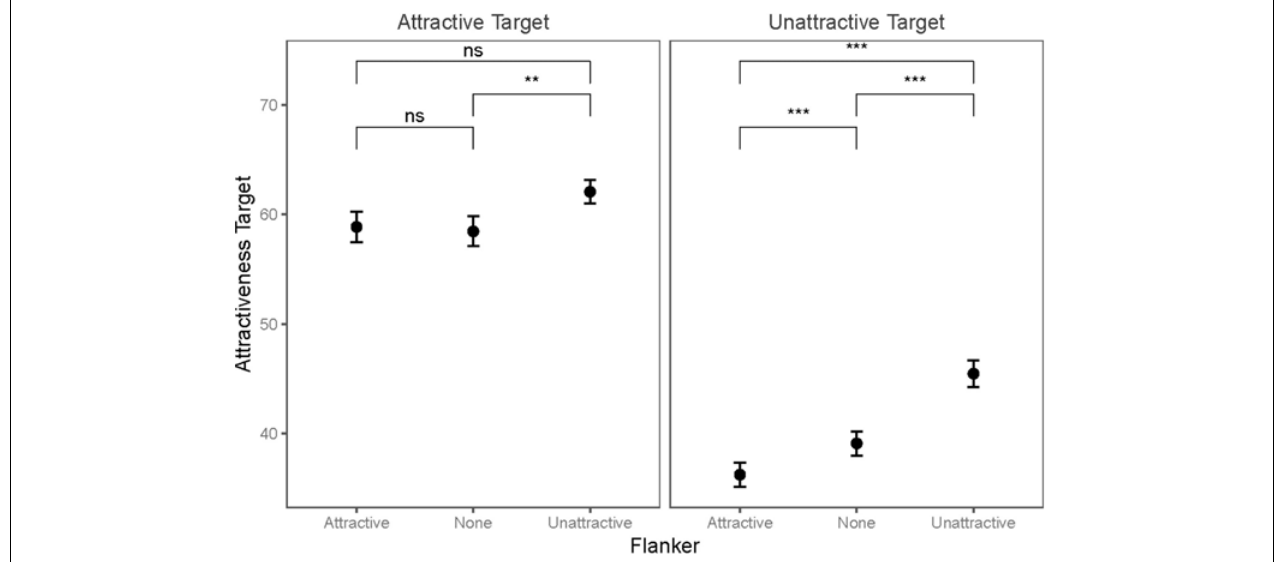
FIGURE 2 | Changes in the attractiveness of faces of low and high attractiveness due to flankers of low and high attractiveness. This figure illustrates the changes in the mean and the 95% confidence interval in the attractiveness of target faces of low and high attractiveness when they are not flanked, and when they are flanked by faces of low or high attractiveness (ns = not significant; * < 0.05; ** < 0.01; *** <